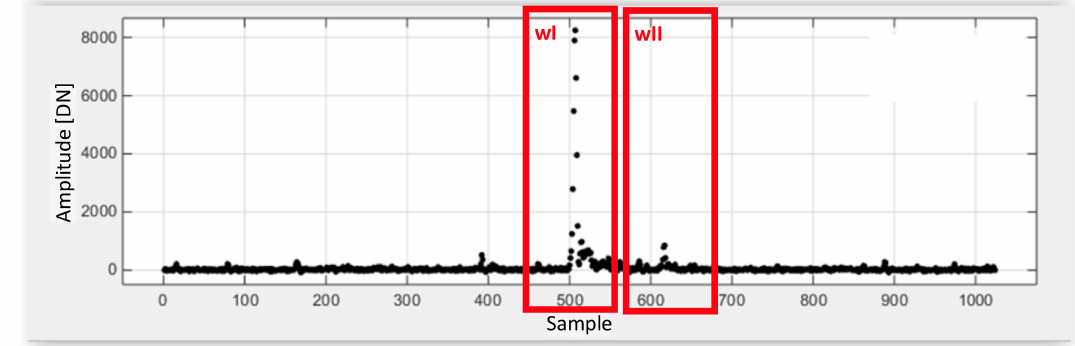
Figure 5. Example full waveform from airborne laser bathymetry with marked windows wI and wII.